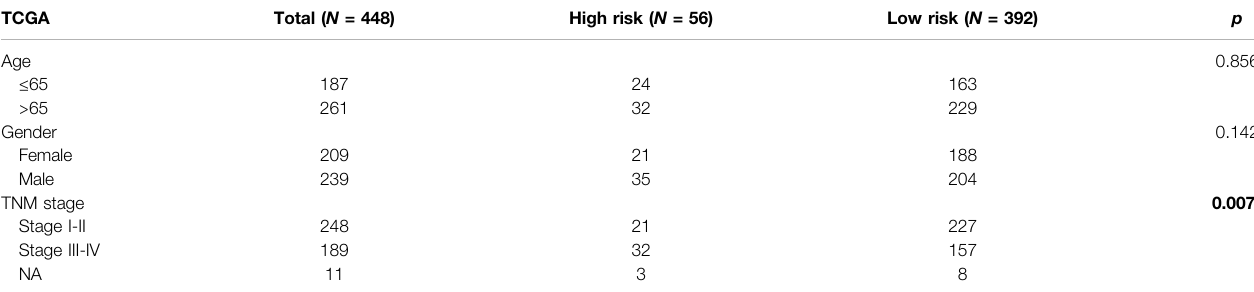
TABLE 1 | The relationship between risk signature groups and clinical indexes in TCGA CRC cohort ( N = 448).